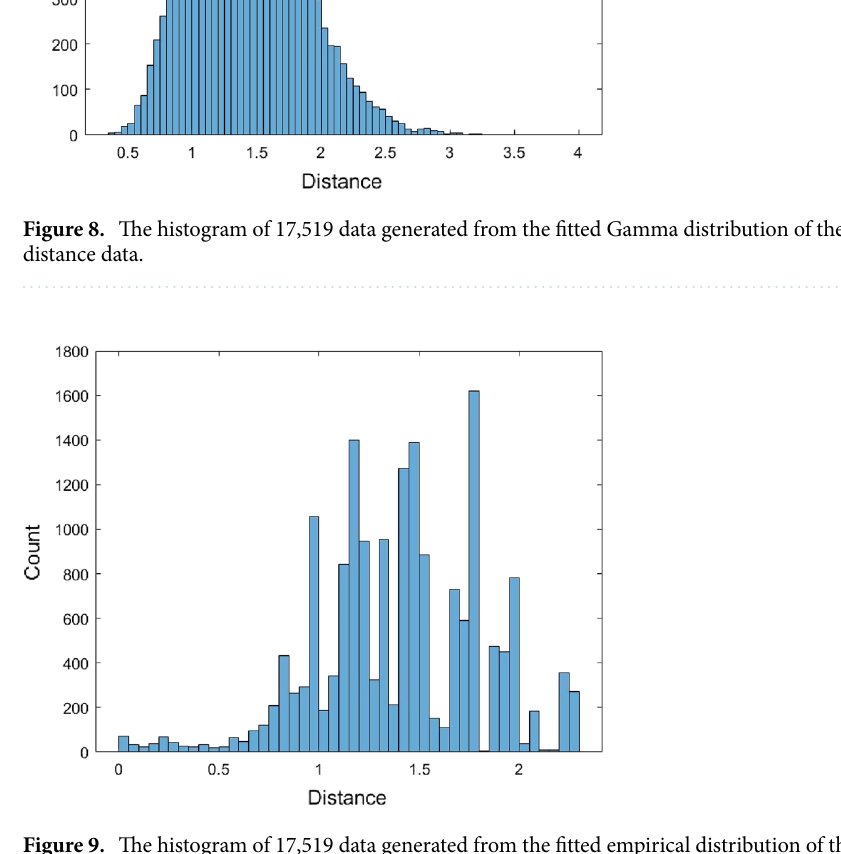
Figure 9. The histogram of 17,519 data generated from the fitted empirical distribution of the Kimura model distance